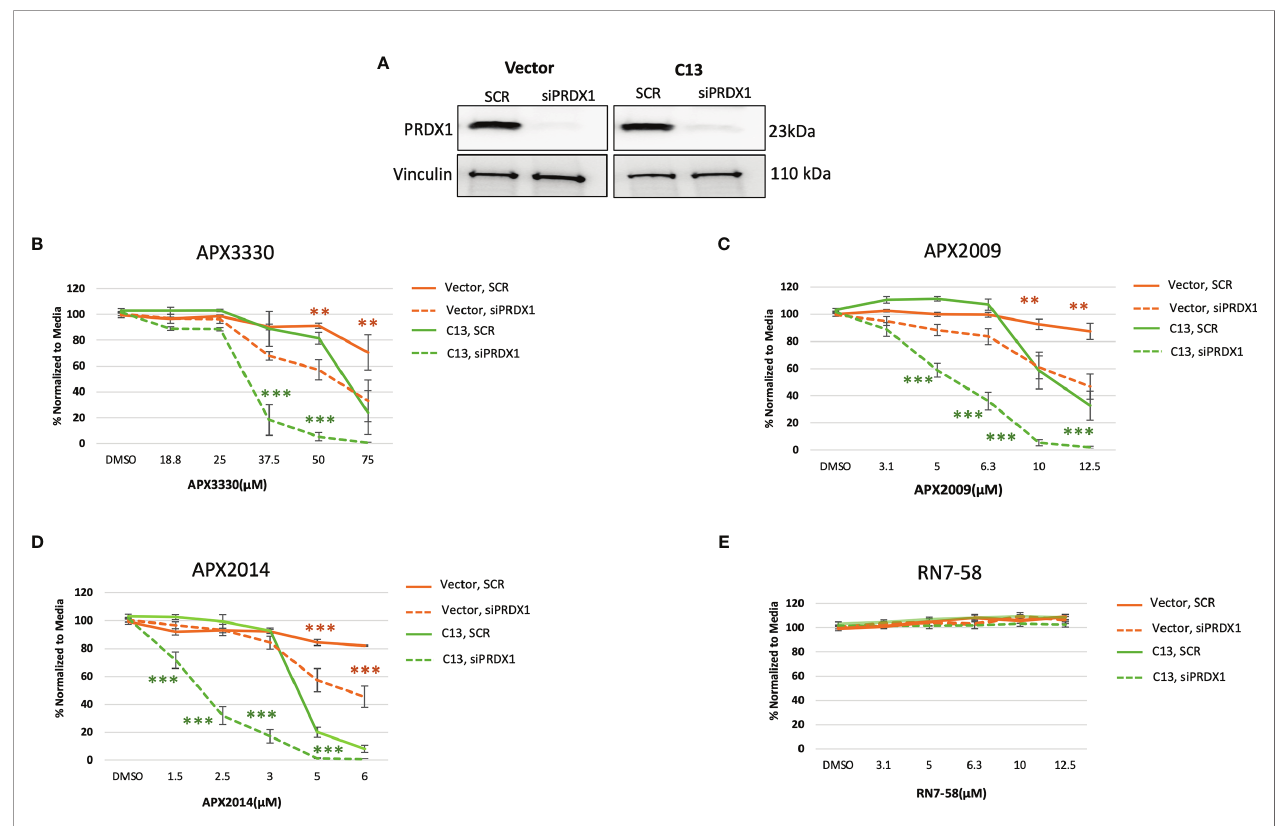
FIGURE 4 | PRDX1 is an effective target enhancing cellular sensitivity to Ref-1 inhibitors in mouse PDAC cells. (A) PRDX1 knockdown ef fi ciency in KC3590 Vector and C13 cell lines were greater than 80% comparing to scrambled control (SCR). Vinculin was used as loading control. (B – D) The cytotoxicity of Ref-1 inhibitors, APX3330, APX2009, APX2014 upon the condition of PRDX1 knockdown both in Vector and C13 were assessed. (E) cytotoxicity of RN7-58 was also evaluated along with Ref-1 inhibitors. Two-way ANOVA, **p < 0.01, ***p < 0.001. At least three independent experiments were performed (N =